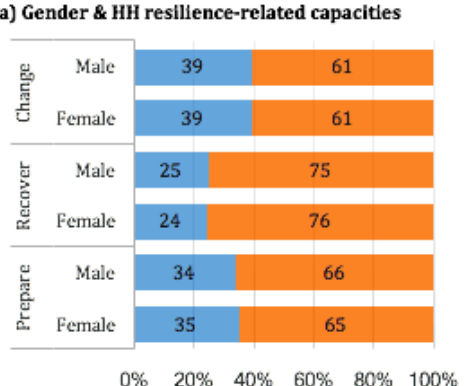
Fig. 2 . Relationships between resilience-related capacities and socioeconomic